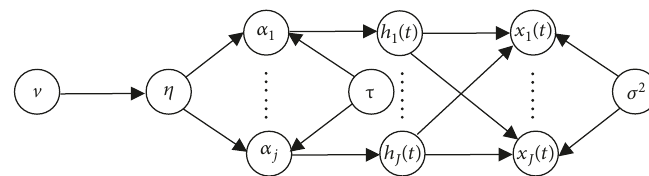
Figure 1: Directed graph of the sparse Bayesian